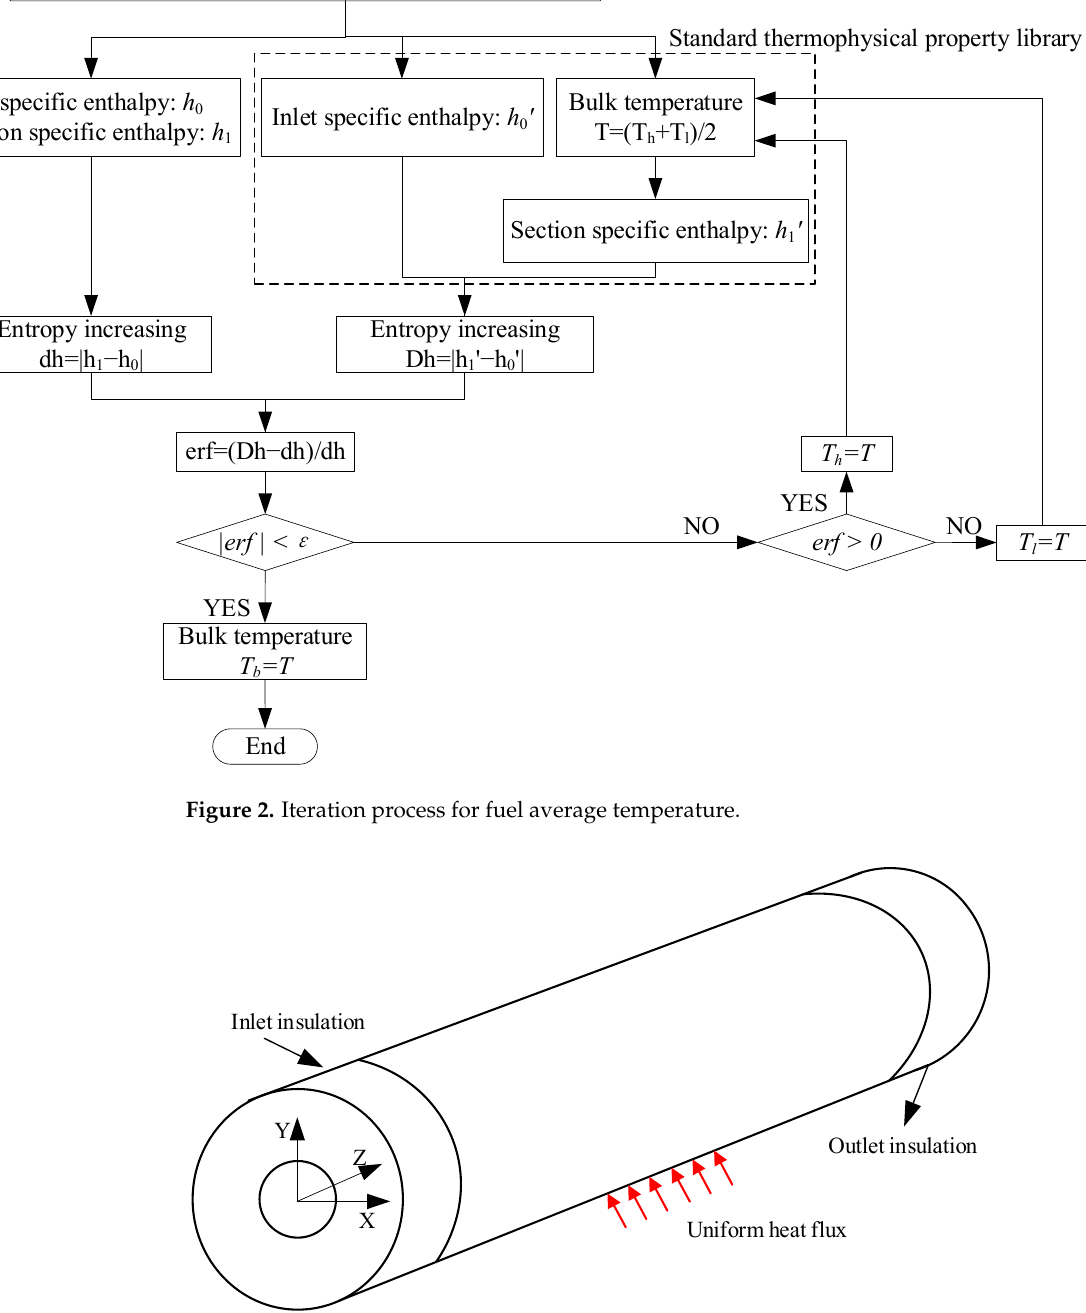
( b ) Fuel temperature Figure 4. Distribution of the velocity and fuel temperature along the radial.